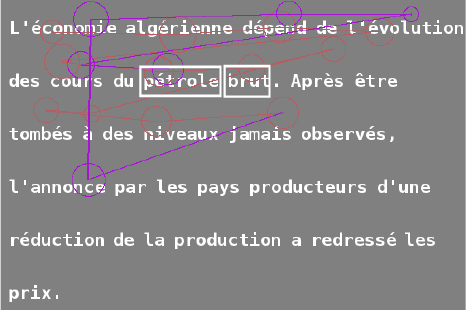
Figure 3. Scanpath of some HR+ text with phase restoration. Tar- get topic is “Oil Price”. Phase 3 (fast reading) is in red and phase 4 (slow confirmation) in purple. Translation: “Algerian economy depends on the evolution of crude oil exchange rates. After they fell down to historically low levels, the announcement by pro- ducing countries of production reduction led to price recovery”. The words framed in white are the closest to target topic (“oil” and